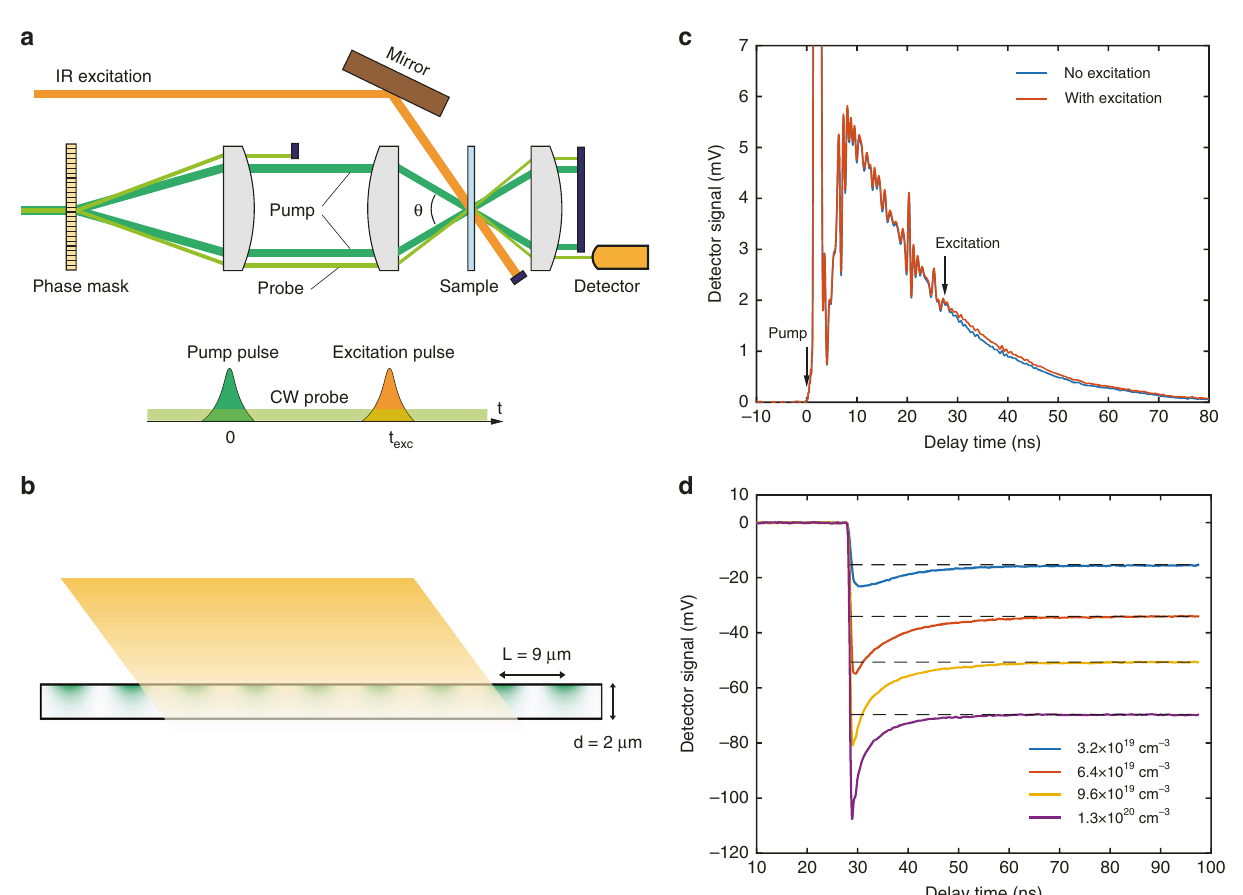
Fig. 1 Experimental set-up and transient thermal response. a Key components showing the pump and probe beams for transient thermal grating, and the photoexcitation beam for generating free carriers. The excitation beam is delayed relative to the pump beams by a time t exc . b Illustration of the absorption of pump (green) and excitation (orange) beams in the silicon membrane. Key dimensions (grating period of 9 μ m and membrane thickness of 2 μ m) are indicated. c Representative transient thermal grating signals obtained with and without photoexcitation. The background signals (obtained with same excitation and probe con fi guration and without pump) are subtracted to ensure zero baseline. The excitation pulse energy was 4.0 μ J. The differences